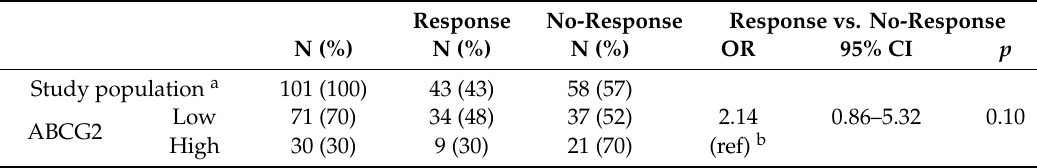
Table 2. Objective response according to biomarker (high/low expression).